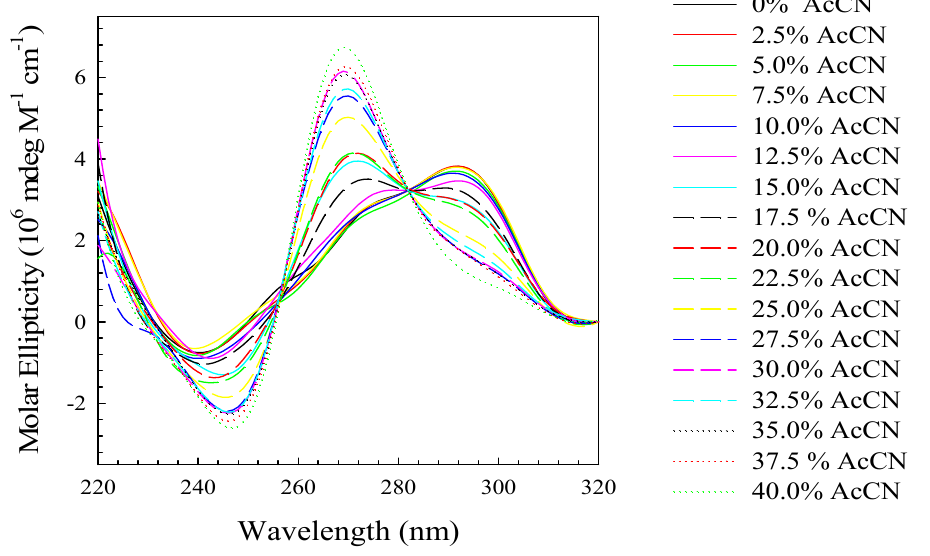
Figure 4. CD spectra at 25 °C in standard potassium phosphate buffer (115 mM K + ) of in the absence or presence of increasing percent acetonitrile (AcCN) as (TTAGGG) 4 indicated on the figure.